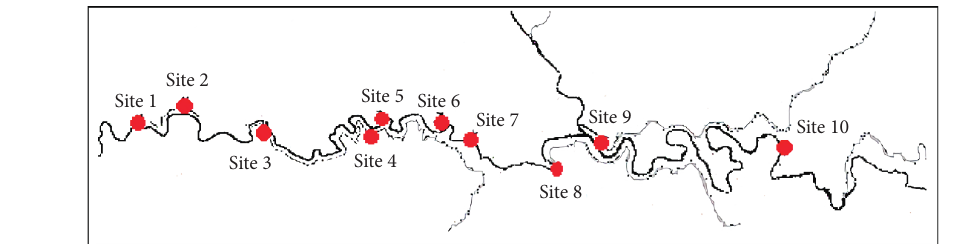
Figure 1: Site 1-Site 10 locations. Table 1: Information about records. Statistics for daily average obs.